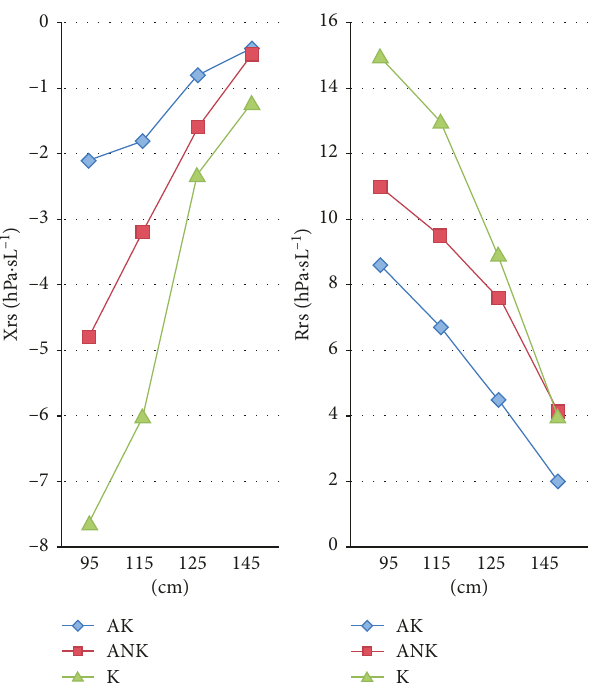
Figure 4: Xrs and Rrs in relation to height. AK: patients with controlled asthma; ANK: patients with uncontrolled asthma; K: control